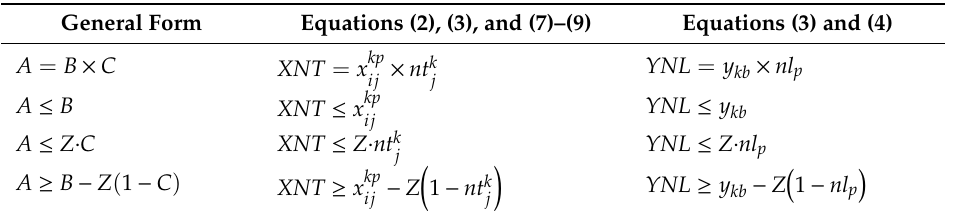
Table 4. Linearization of non-linear